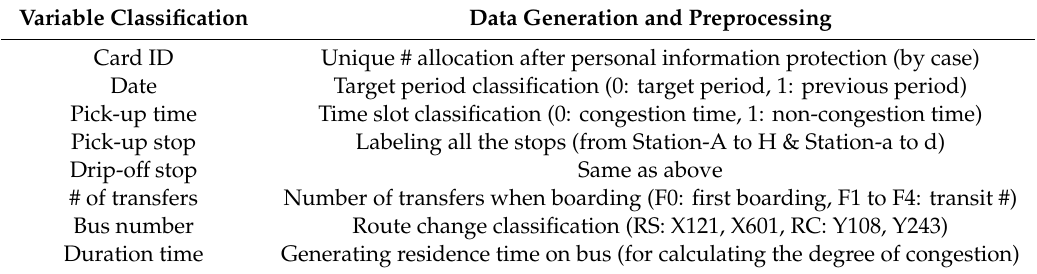
Table 7. Data generation and preprocessing through variable